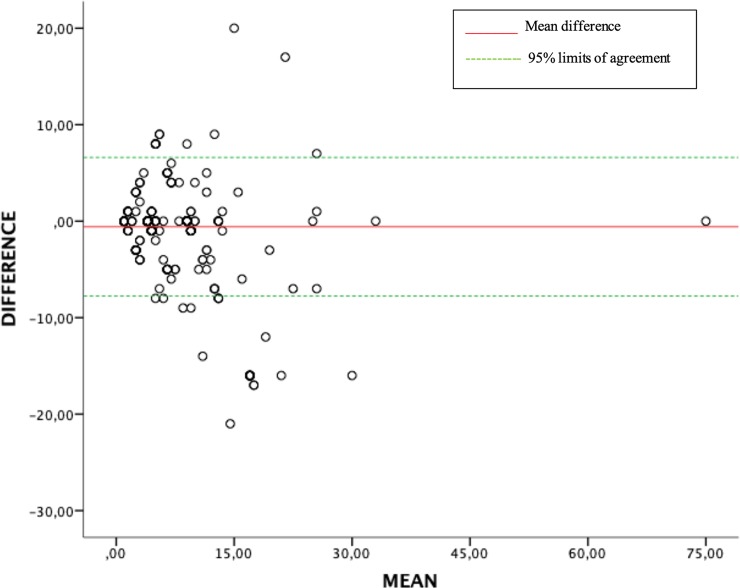
Bland–Altman plot.The difference between converted ISS with respect to manual coding is drawn against the mean of automated and manual coding in the measurements in the study.